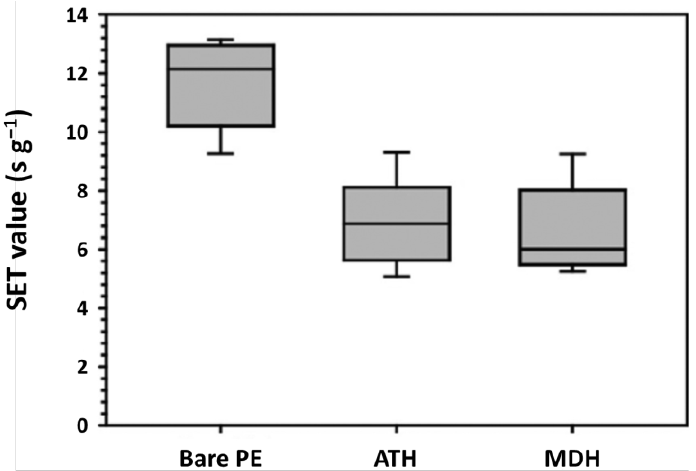
Figure 32. Self-extinguishing time (SET) values of separators, showing that the SETs of the aluminum hydroxide (ATH) and magnesium hydroxide (MDH) separators were much lower than that of the bare PE separator. Reprinted with permission from Ref. [86]. Copyright 2015, Elsevier.